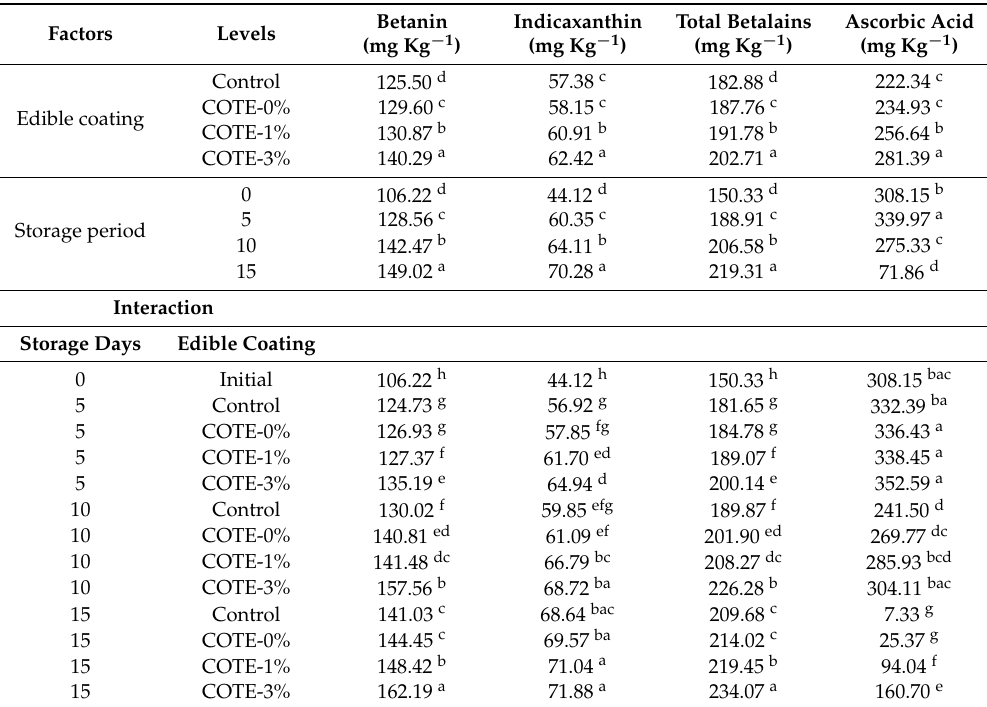
Table 3. Effect of edible coating incorporated with tomato oily extract and storage period on betanin, indicaxanthin, total betalains and ascorbic acid contents of Myrtillocactus geometrizans fruits during